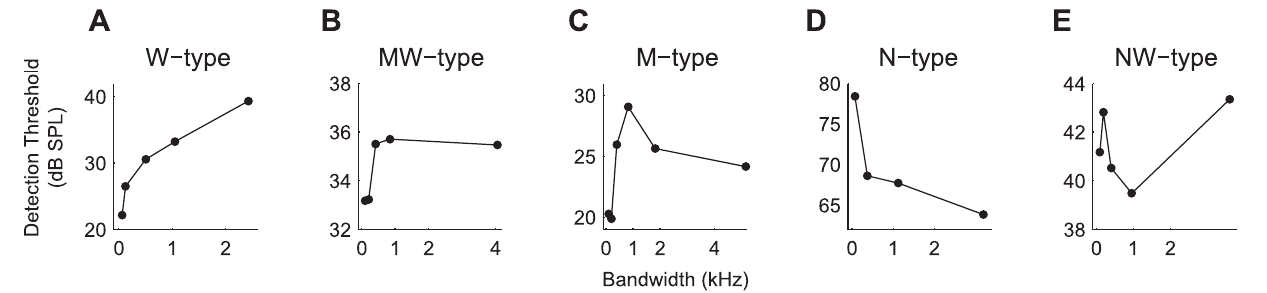
Figure 7. Differential effects of masker bandwidth on probe detection threshold for M m . The different response types that were observed were: A: a monotonic increase in probe detection threshold for increasing noise bandwidths (W-type neurons). B: a monotonic increase in detection threshold that levels off (MW-type), C: an initial increase followed by a decrease in threshold at increasing bandwidths (M-type), D: a systematic decrease in detection threshold with increasing bandwidth (N-type). E : an initial decrease followed by an increase in threshold at increasing bandwidths (NW-type).